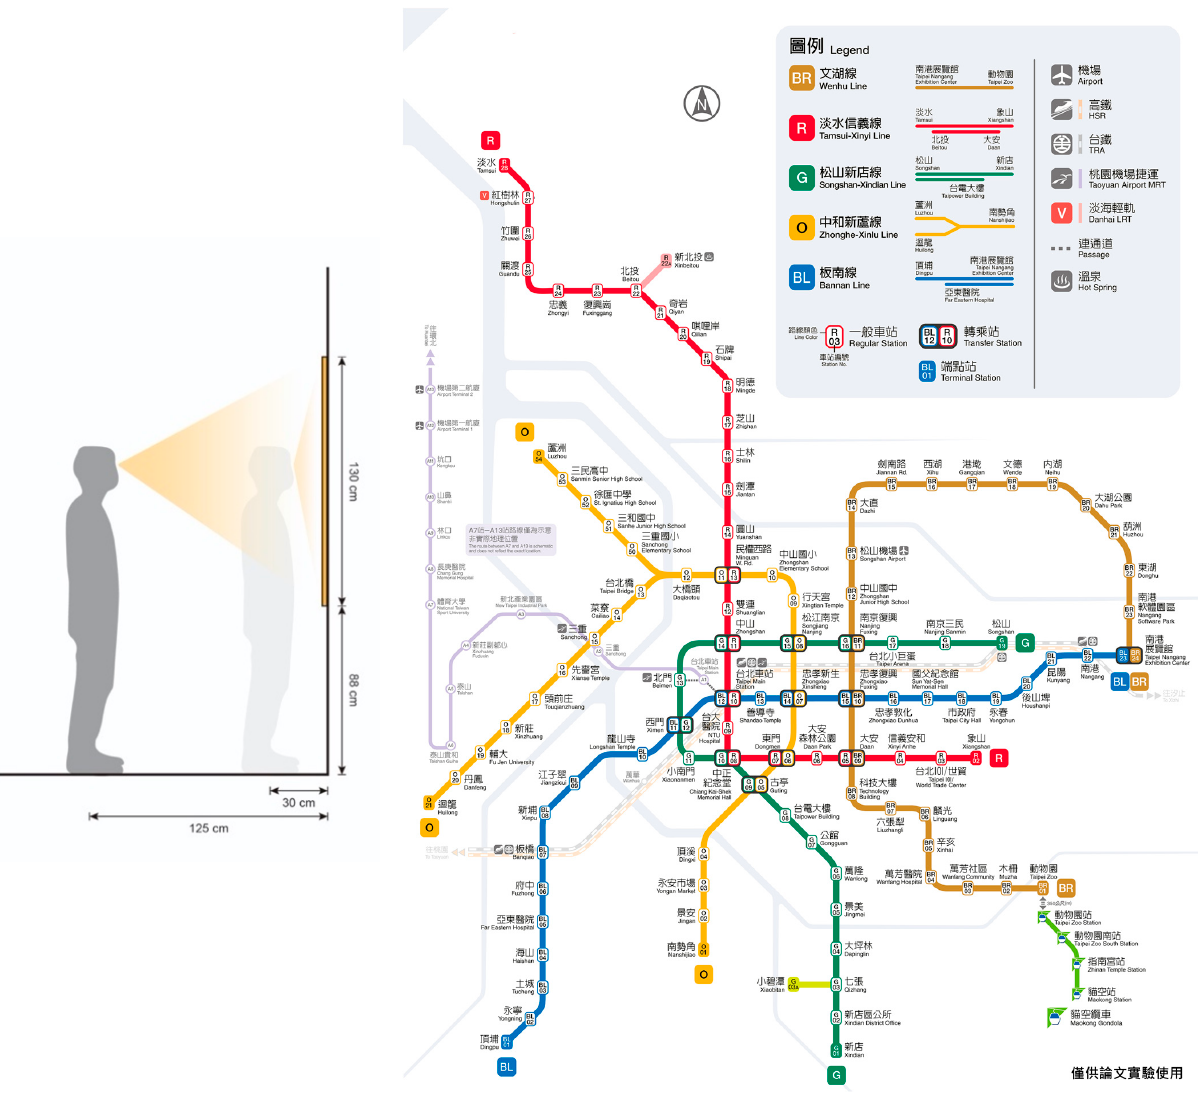
Figure 2. Present route map.